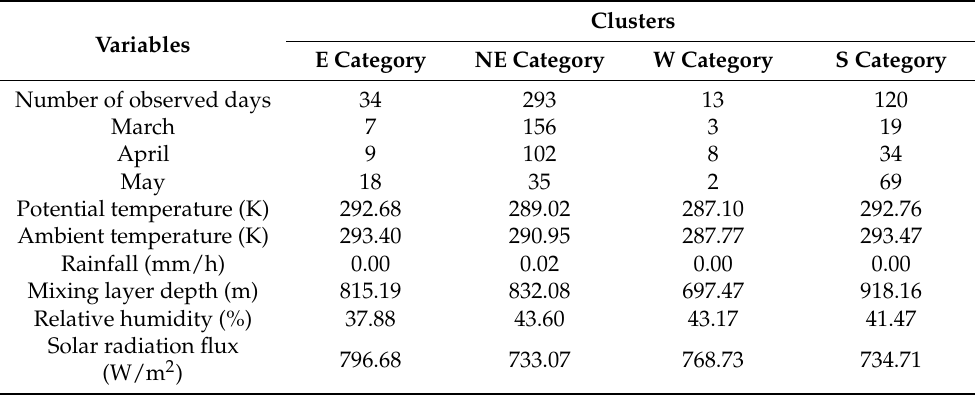
Figure 3. Trajectory pattern of each cluster and their altitudes along with pathway. Table 1. Occurrence frequency and meteorological characteristics of each